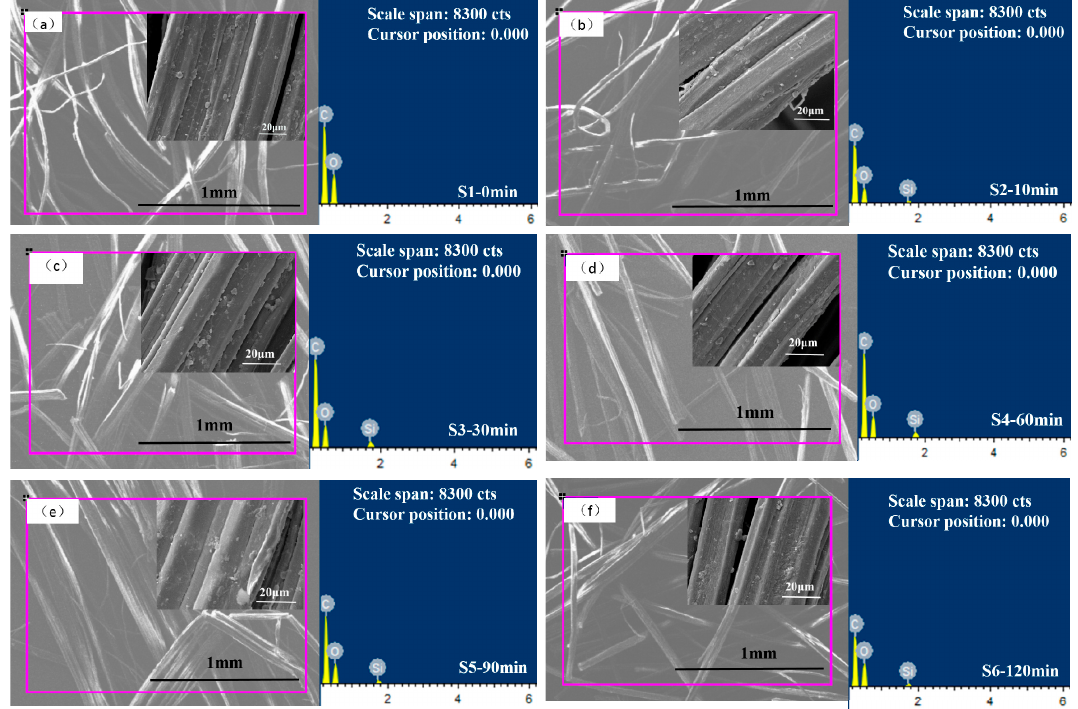
Figure 5. SEM and energy dispersive spectrometer (EDS) analysis of ( a ) unmodified jute fiber and ( b , c , d , e and f ) KH-560-modified jute fibers. Table 2. The elements and their contents for unmodified and KH-560-modified jute fibers.